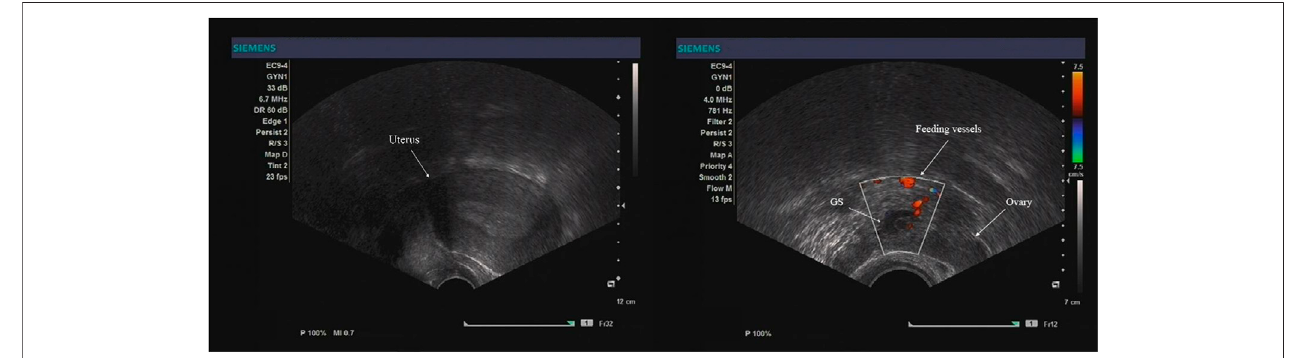
FIGURE 1 | Ultrasound image of the left ovarian ectopic pregnancy, showing the GS with a yolk sac inside and feeding vessels around.